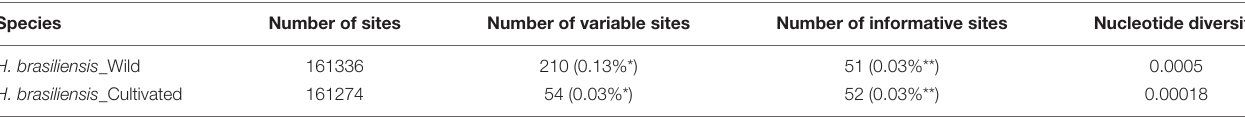
* The percentage of variable sites in the number of sites. ** The percentage of informative sites in the number of variable